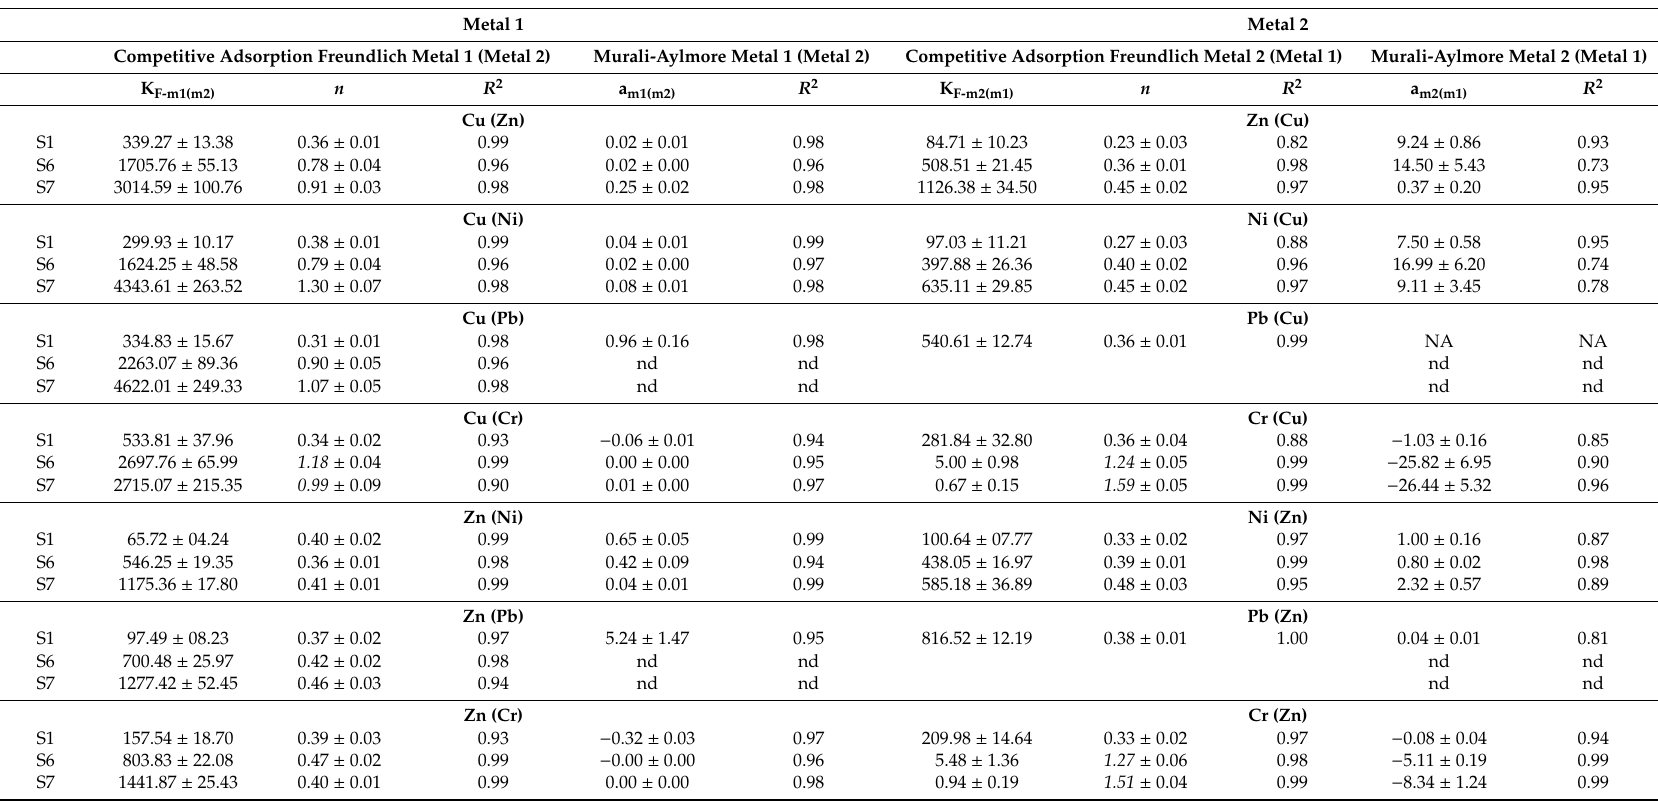
Table 6. Competitive adsorption results. Parameters derived from Freundlich model fitted with competitive adsorption data and parameters derived from Murali-Aylmore model fitted with single adsorption